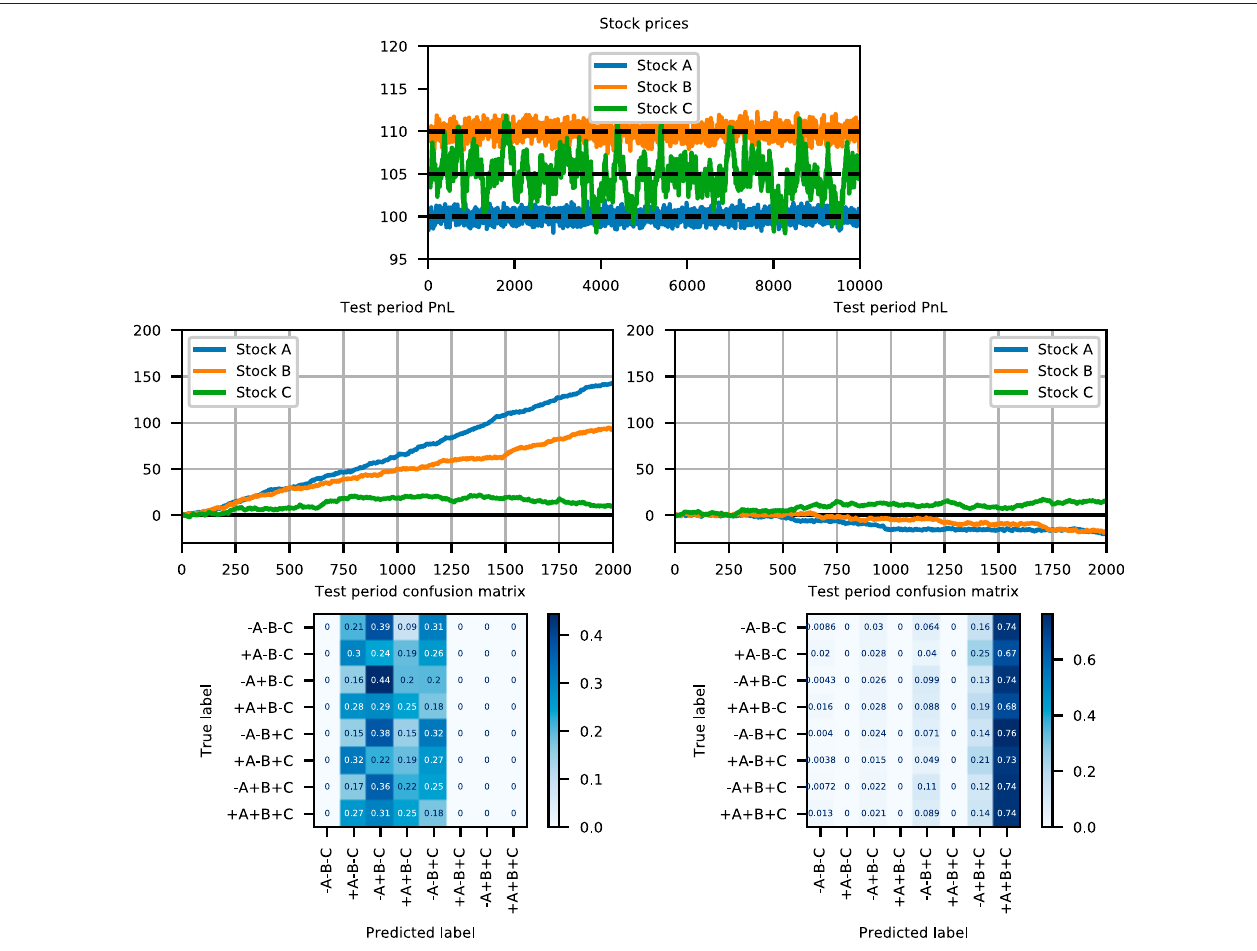
FIGURE4| Fromtoptobottom,lefttoright:Simulatedstockprices,testperiodPnL(Pro fi tandLoss)fortheGMT,testperiodPnLfortheneuralnetwork,confusion matrix for the GMT, and confusion matrix for the neural network. The PnL is the cumulative pro fi t achieved when the predicted portfolios are executed. The costs are omitted for